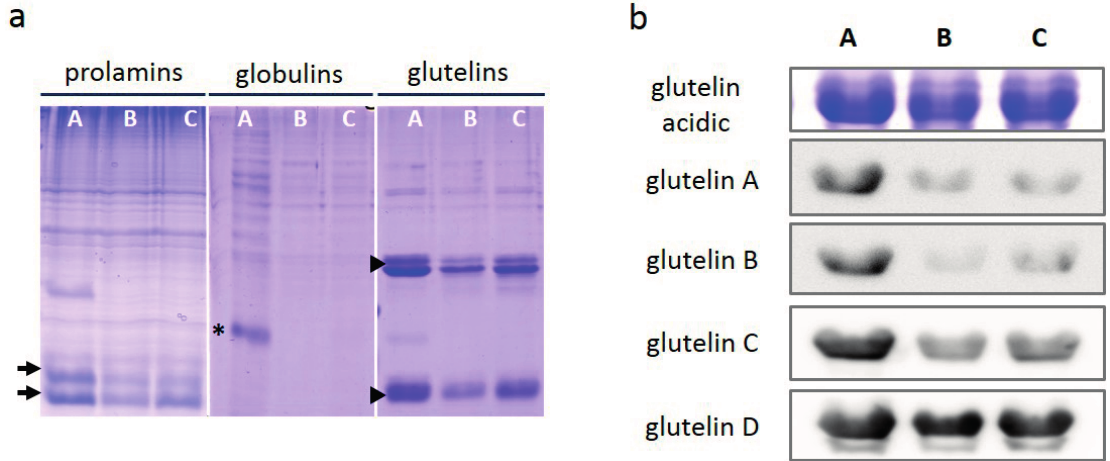
Figure 3. Accumulation of three different types of storage proteins in Glb-RNAi seeds. ( a ) Ground seed powder (50 mg) was fractionated based on solvent solubility, and the three fractionated extracts were resolved on an sodium dodecyl sulfate-polyacrylamide gel and stained in Coomasie Brilliant Blue (CBB) staining solution. arrows, prolamins; asterisk, globulins; arrow heads, glutelins; ( b ) The glutelin-containing extracts were used for an immunoblotting analysis. The immune signals recognized by the anti-glutelin antibodies were detected by a luminescent image analyzer (LAS-4000, Fujifilm). A, wild type; B, Glb-RNAi 1–6; C, Glb-RNAi